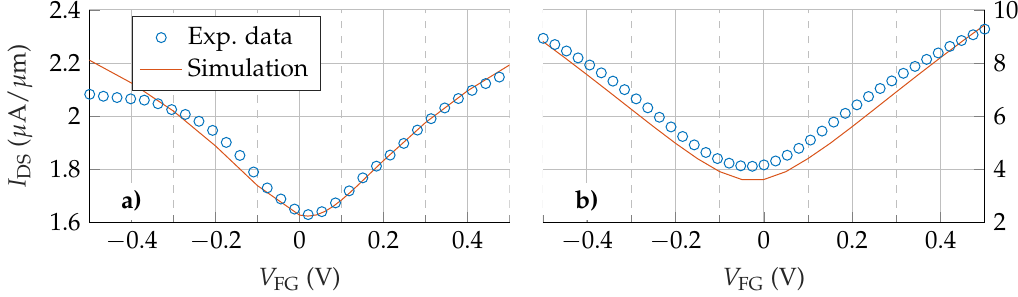
Figure 2. Comparison between the simulation results and the experimental data extracted from [29] ( a ) and [30] ( b